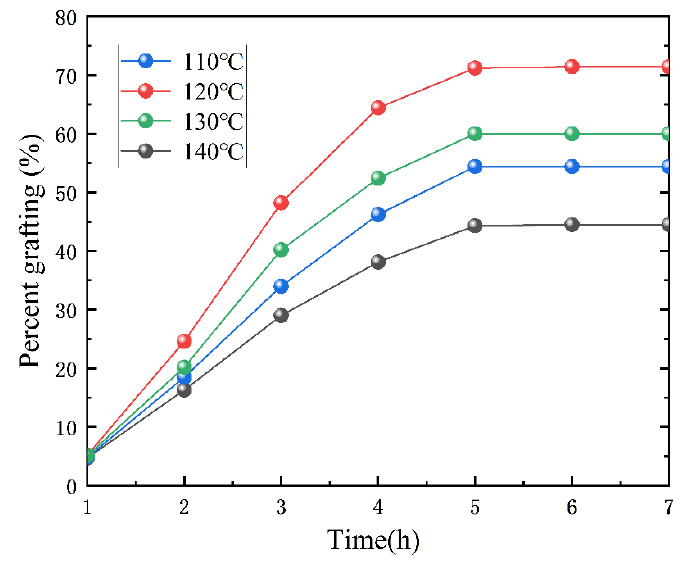
Figure 6. Effect of different temperatures on the grafting ratio. Table 4. Effect of different temperatures on the water dispersibility of the resin.